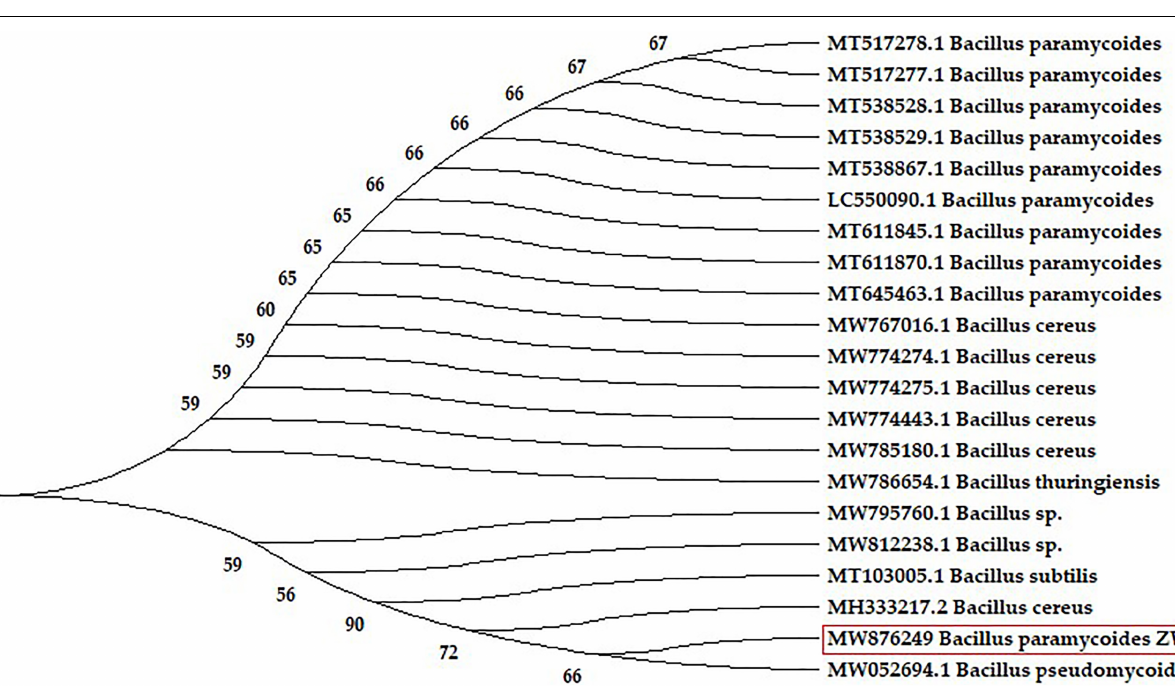
The assumptions of the analysis of PBD were checked, employing the residual analysis. Plotting the normal probability plot of the residuals ( Figure 5 ) shows that the residuals are normally distributed and follow, approximately, a straight line. Also, the residual versus fits plot indicates that the residual